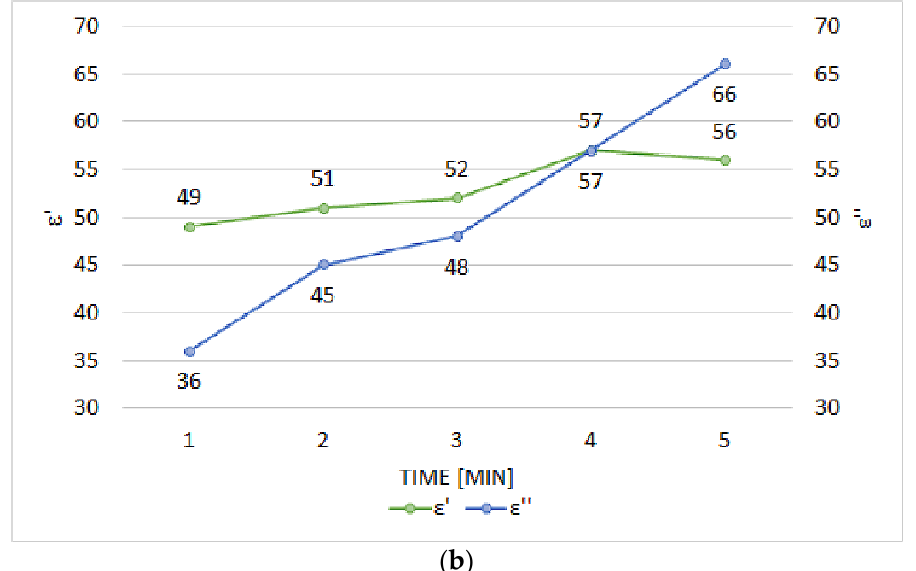
Figure 1. Permittivity of the load at 2.45 GHz: ( a ) as a function of temperature; ( b ) as a function of the holding time at 353.15 K (80 °C).